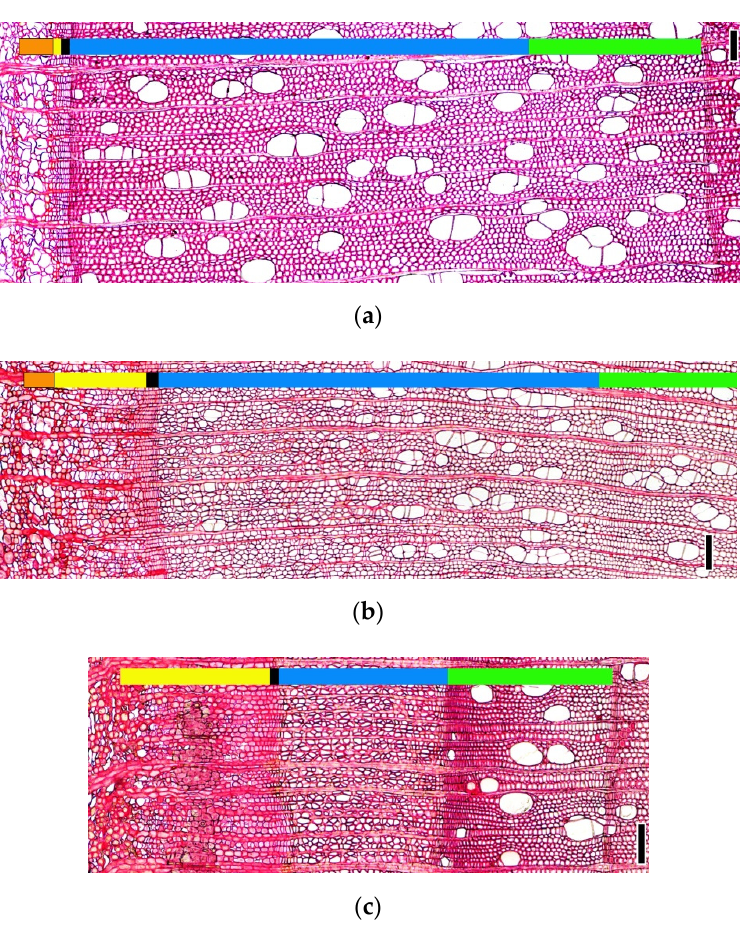
Figure 4. Structure of trunk conducting tissues at the end of the growing season: ( a ) control tree; ( b ) girdled tree, AG35 level; ( c ) girdled tree, AG1 level. Colors show the following tissue layers: Green: xylem formed before the experiment; blue: xylem formed after the experiment; black: cambial zone: yellow: late phloem; orange: early phloem. Scale bar is 100 µm.